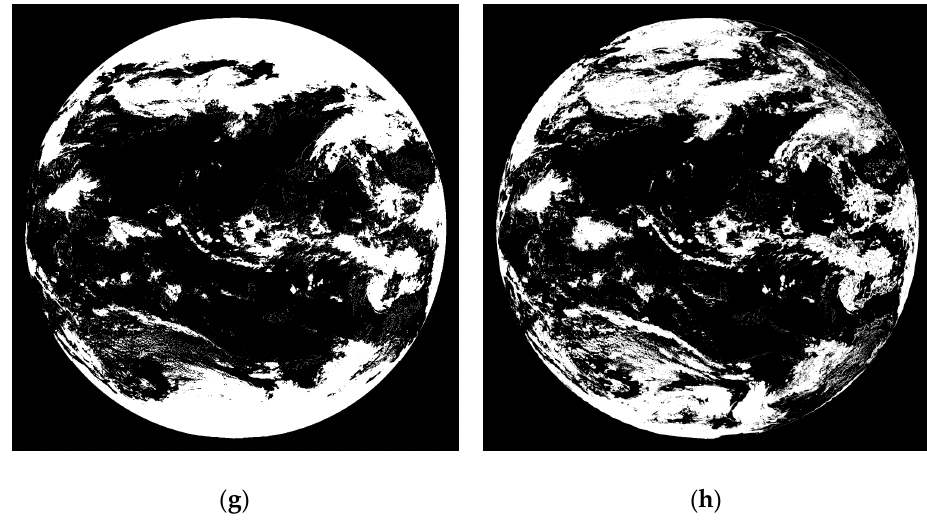
Figure 7. The cloud detection results of all employed methods at 16:30 on 17 March 2015. ( a ) Visible image; ( b ) IR1 image; ( c ) IR2 image; ( d ) NSMC cloud detection result; ( e ) Ensemble threshold result; ( f ) NSMC-RF cloud detection result; ( g ) Ensemble threshold-RF cloud detection result; ( h ) Proposed RF cloud detection result.